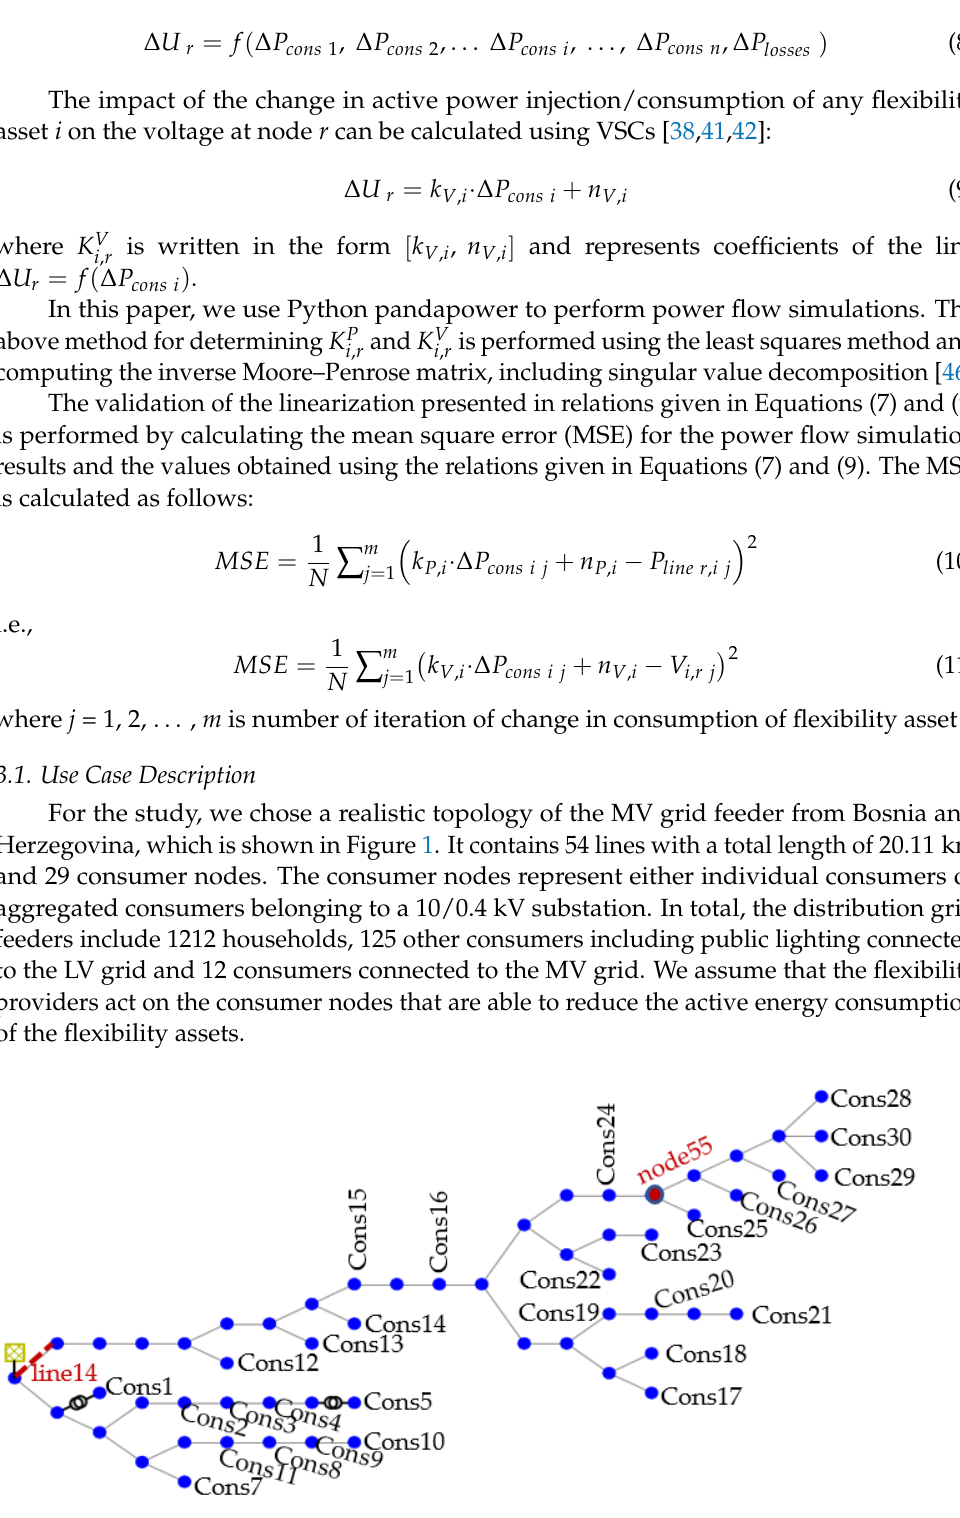
Figure 1. Use case: The MV grid feeders from Bosnia and Herzegovina.